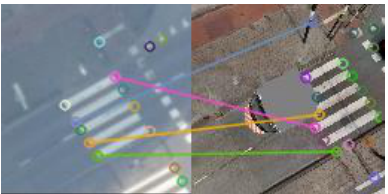
Figure 9 Matched LATCH keypoints in the first scene and first iteration